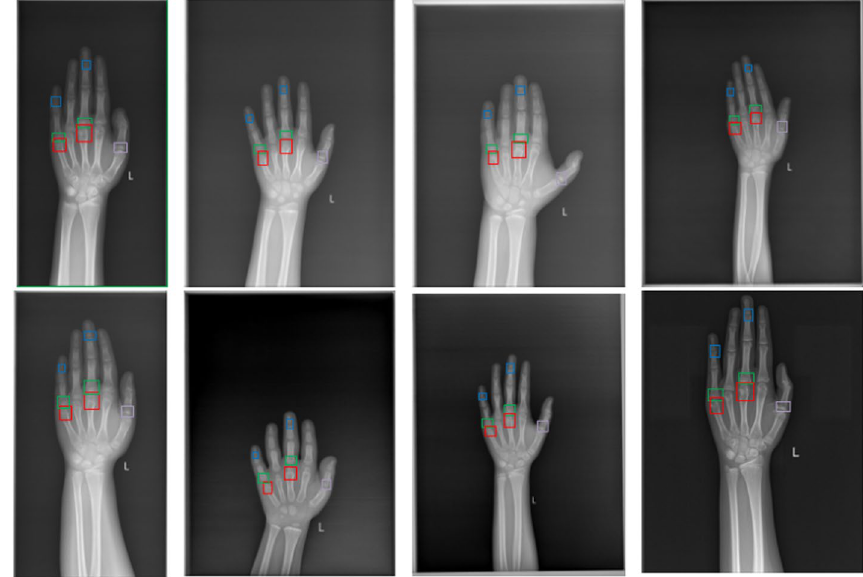
Fig. 11 Samples of annotations of the 3rd metacarpal and 5th metacarpal (red), 3rd proximal phalanx, 5th proximal phalanx (green), 3rd distal phalanx and 5th distal phalanx (blue), and the 1st proximal phalanx (purple). There is an overlap of the red and green boxes, which indicates that the prediction of the 3rd and 5th metacarpal and the 3rd and 5th proximal phalanx will be more difficult than the prediction of the 1st proximal phalanx